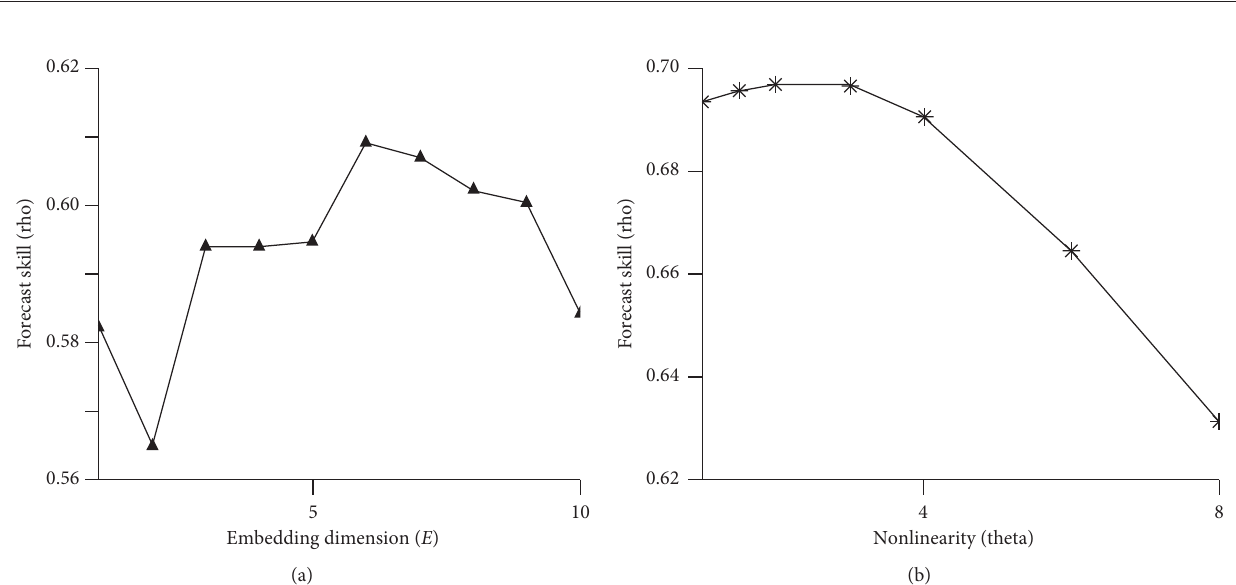
Figure 4: The embedding dimension and nonlinear analysis of travel time series. (a) Simplex projection. (b) S -map nonlinear analysis.